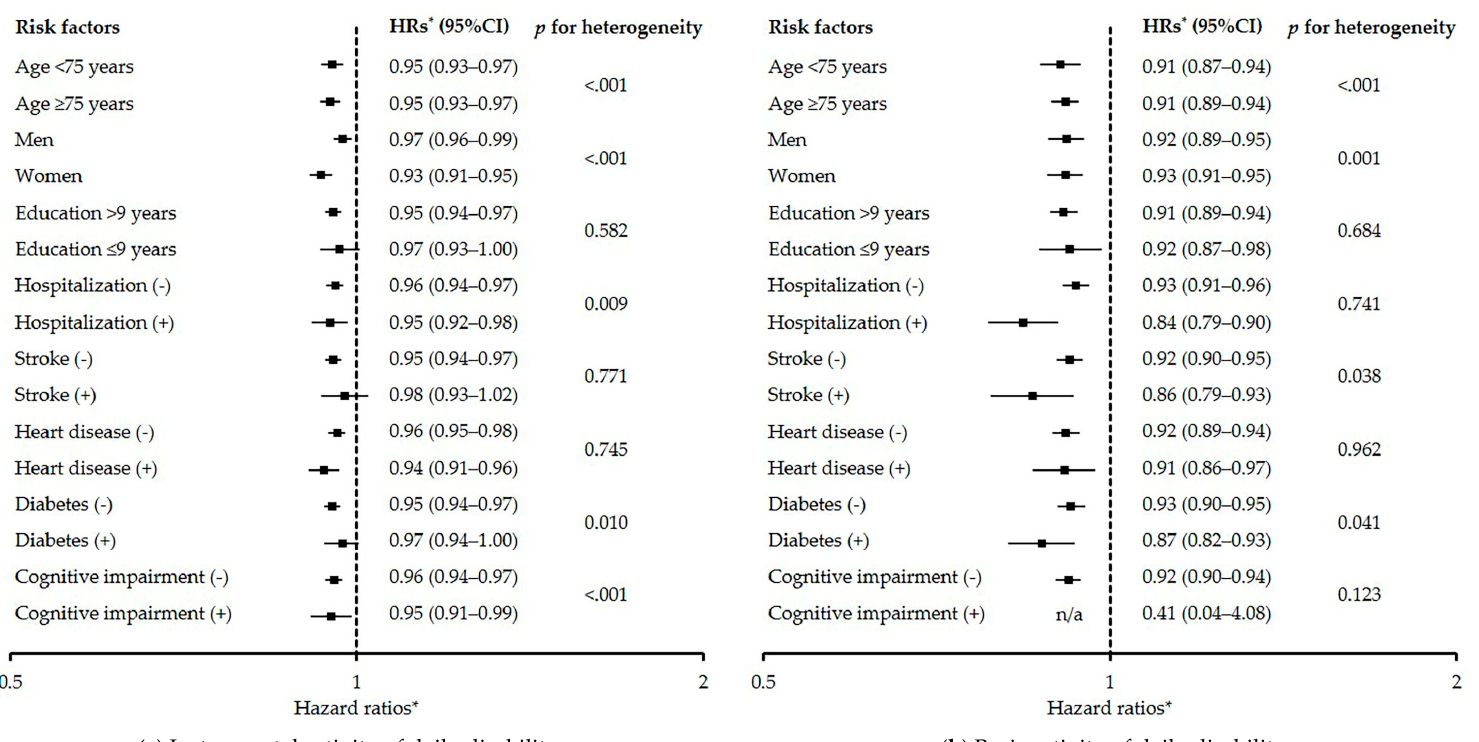
Figure 4. The influence of sarcoscore (for +1 point) on the risk of disabilities of instrumental activities of daily living and basic activities of daily living according to the subgroup of potential risk factors. Squares indicate point estimate of adjusted hazard ratio, and bars indicate 95% confidence intervals. *: Adjusted for age, sex, cohort area, low education level, hospitalization, stroke, heart disease, diabetes, and cognitive impairment. n/a: not applicable. The variables relevant to the subgroup were excluded from the corresponding model.